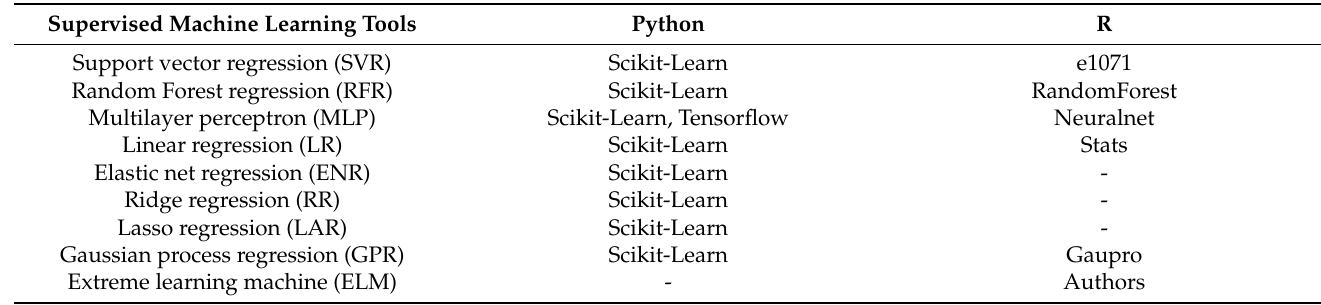
Table 1. Tools implemented to construct